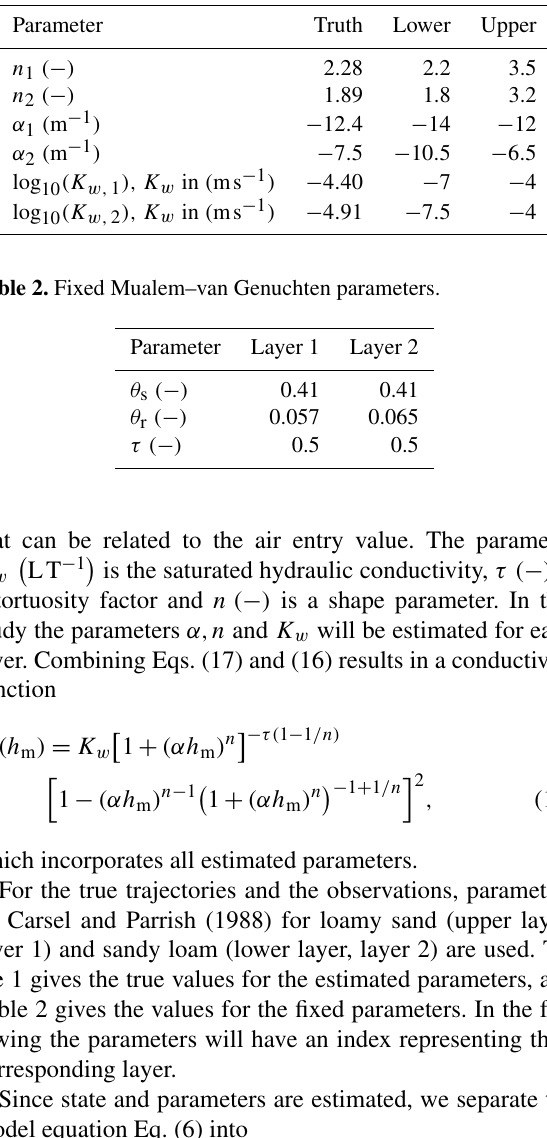
Table 1. True Mualem–van Genuchten parameters and range of the uniformly distributed initial guess.